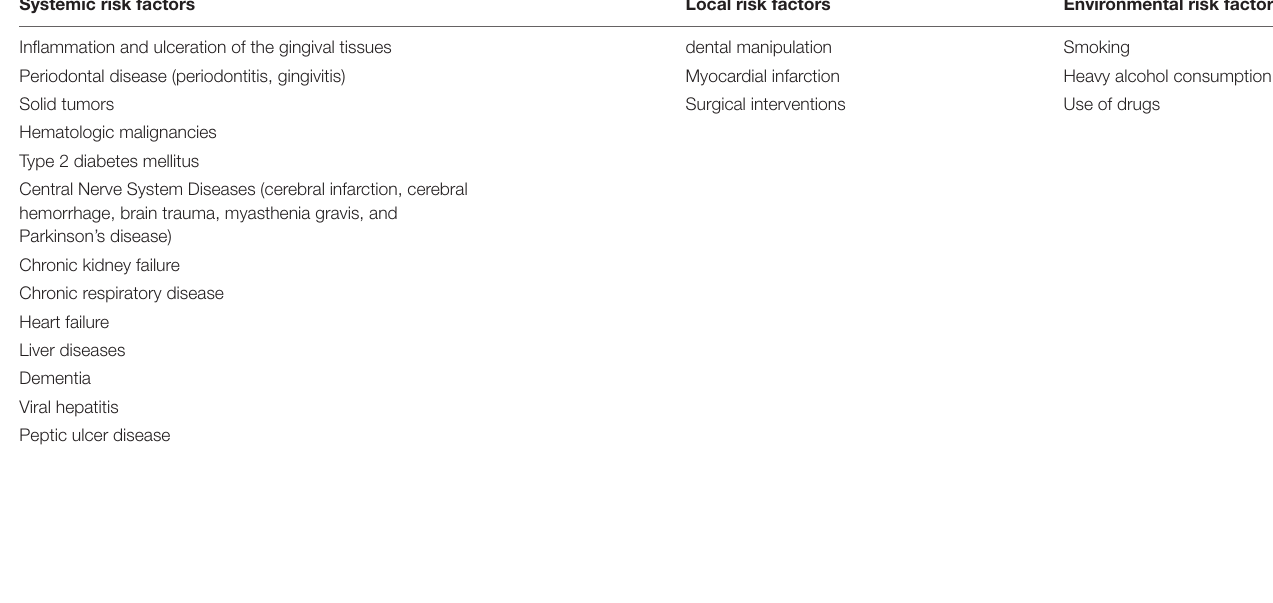
TABLE 3 | Risk factors of infection with the Streptococcus anginosus group